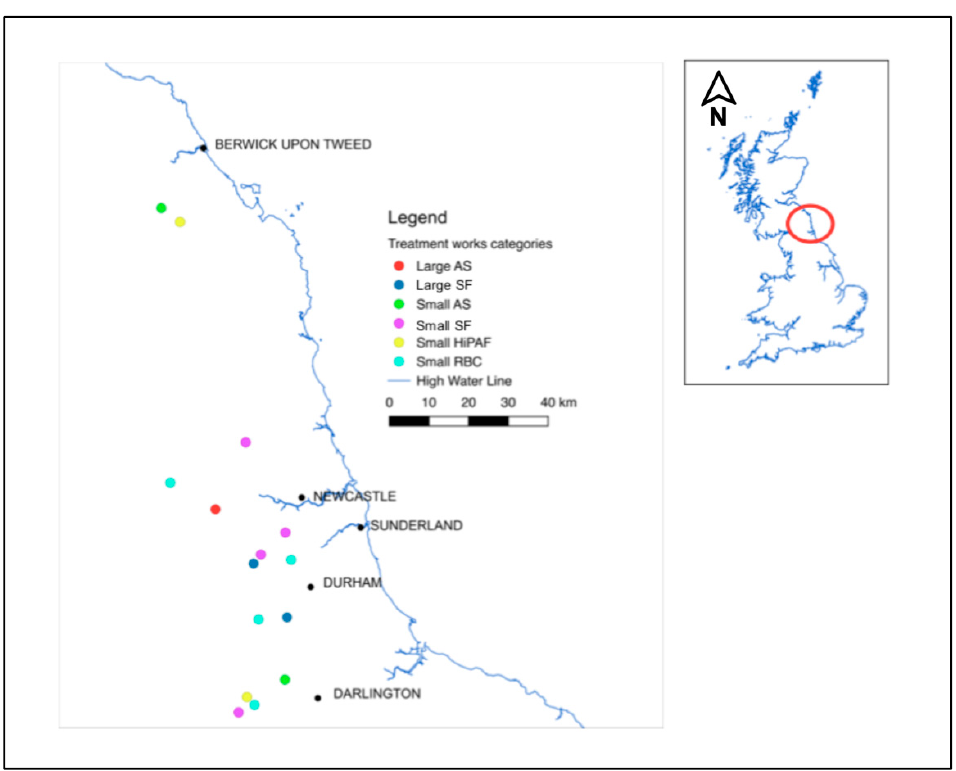
Figure A1. Location of WWTPs sampled by treatment plant type. AS is activated sludge, SF is secondary filtration, HiPAF is high performance aerated filter, and RBC is rotating biological contactor. Table A1. Performance criteria of three models tested to predict the reliability of small WWTPs. MSE is the mean standard error.